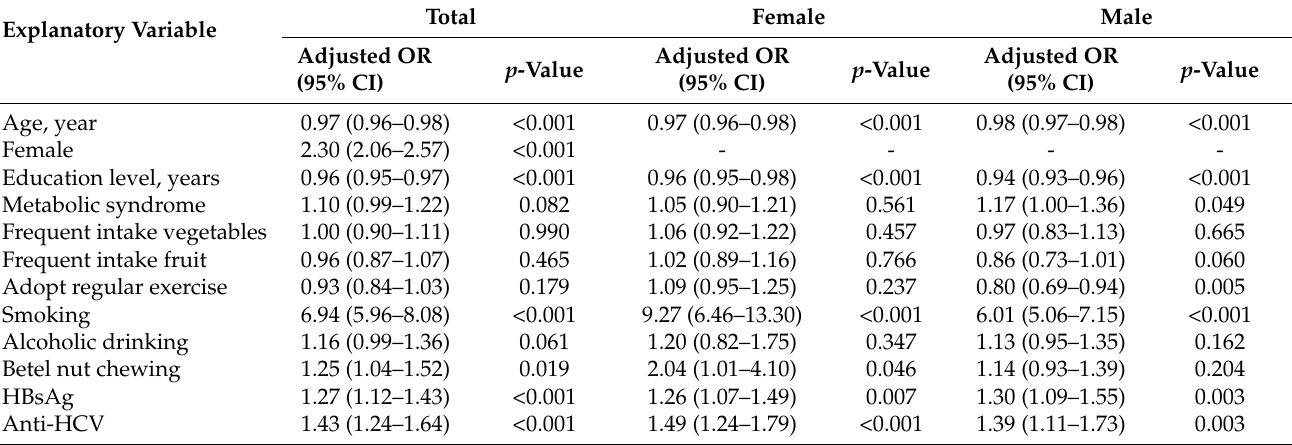
Table 3. Association between the demographic characteristics and the risk of higher level of